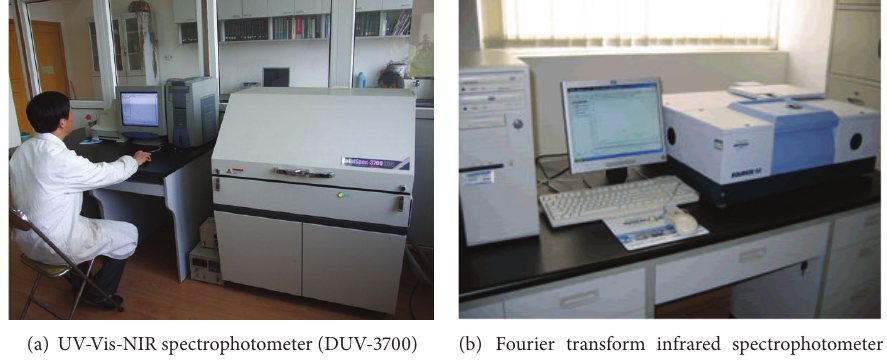
Figure 3: The spectral testing